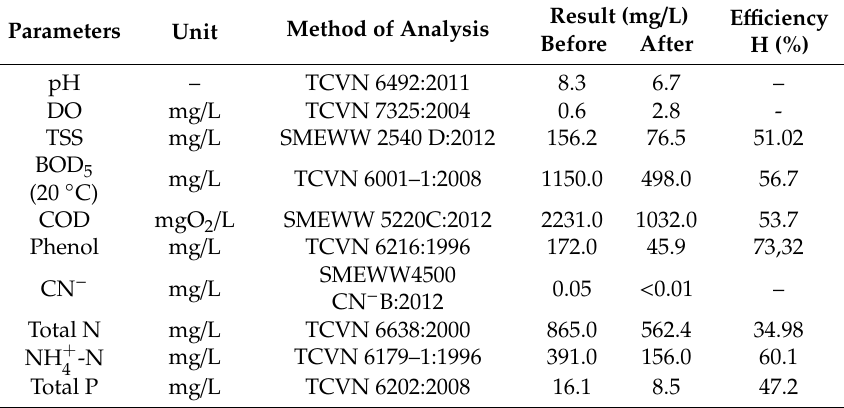
Figure 7. Chromatogram of the phenol containing wastewater after treatment with Fe-C internal electrolyte material. Table 3. Characteristics of coking wastewater before and after internal electrolysis treatment with Fe-C